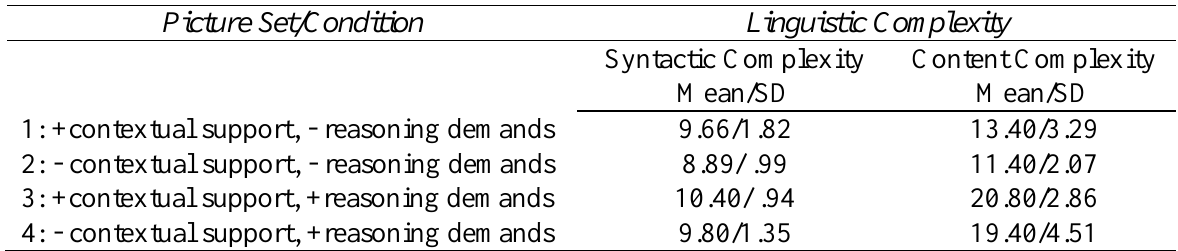
Descriptive Statistics for First Comparison Group (n=5)